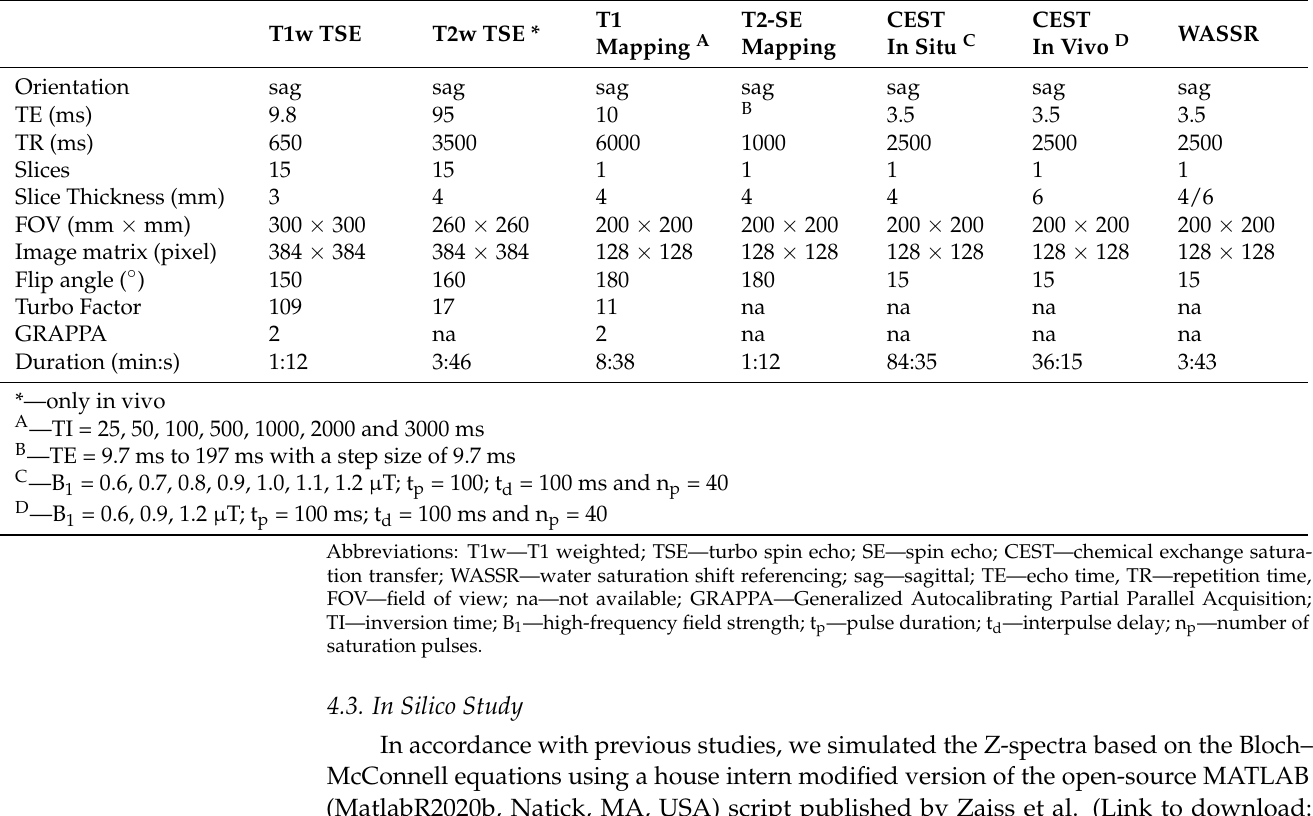
Table 3. Magnetic resonance imaging sequence